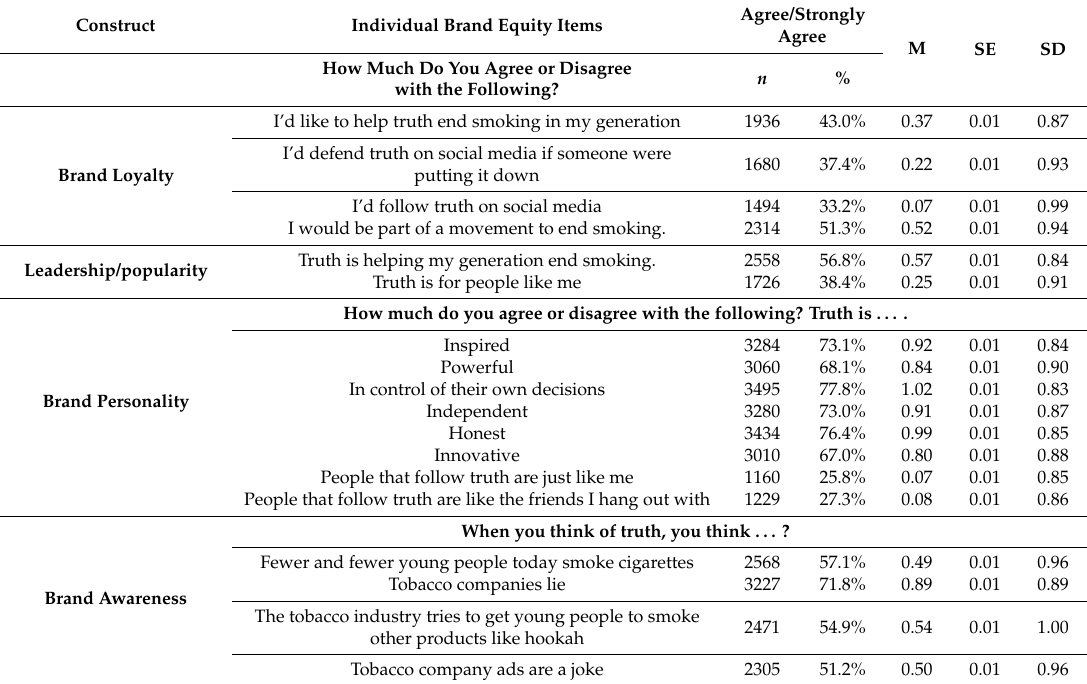
Table 1. Weighted responses to individual Brand Equity scale items ( n =